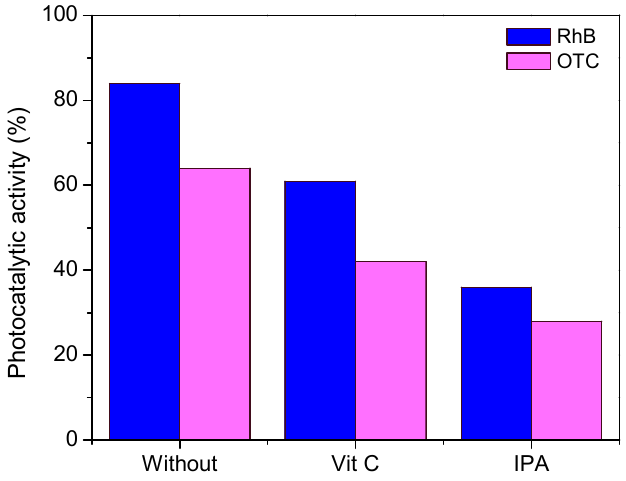
Figure 15. The effect of scavengers on the RhB and OTC